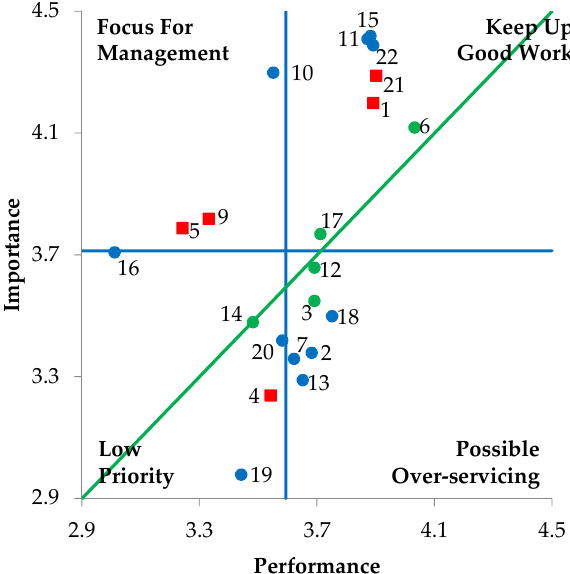
Figure 3. Combination Data-Centered and Gap Analysis Importance-Performance Analysis. Attributes are shown as a red square shown if there was not a significant correlation between the Importance and Performance ratings. For attributes shown as a green dot Performance = Importance. Attributes shown as a blue dot have non-zero gaps and Performance (cid:54) =